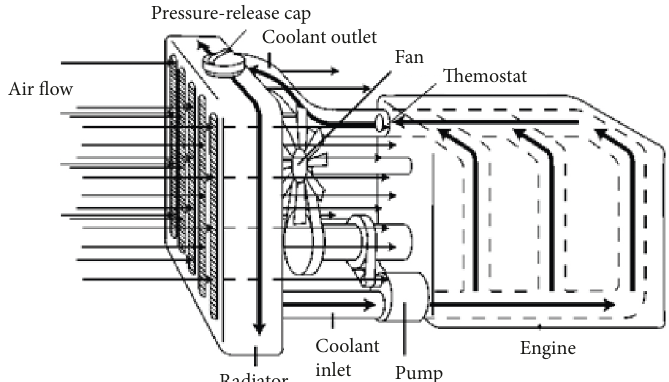
Figure 13: Components within an automotive cooling